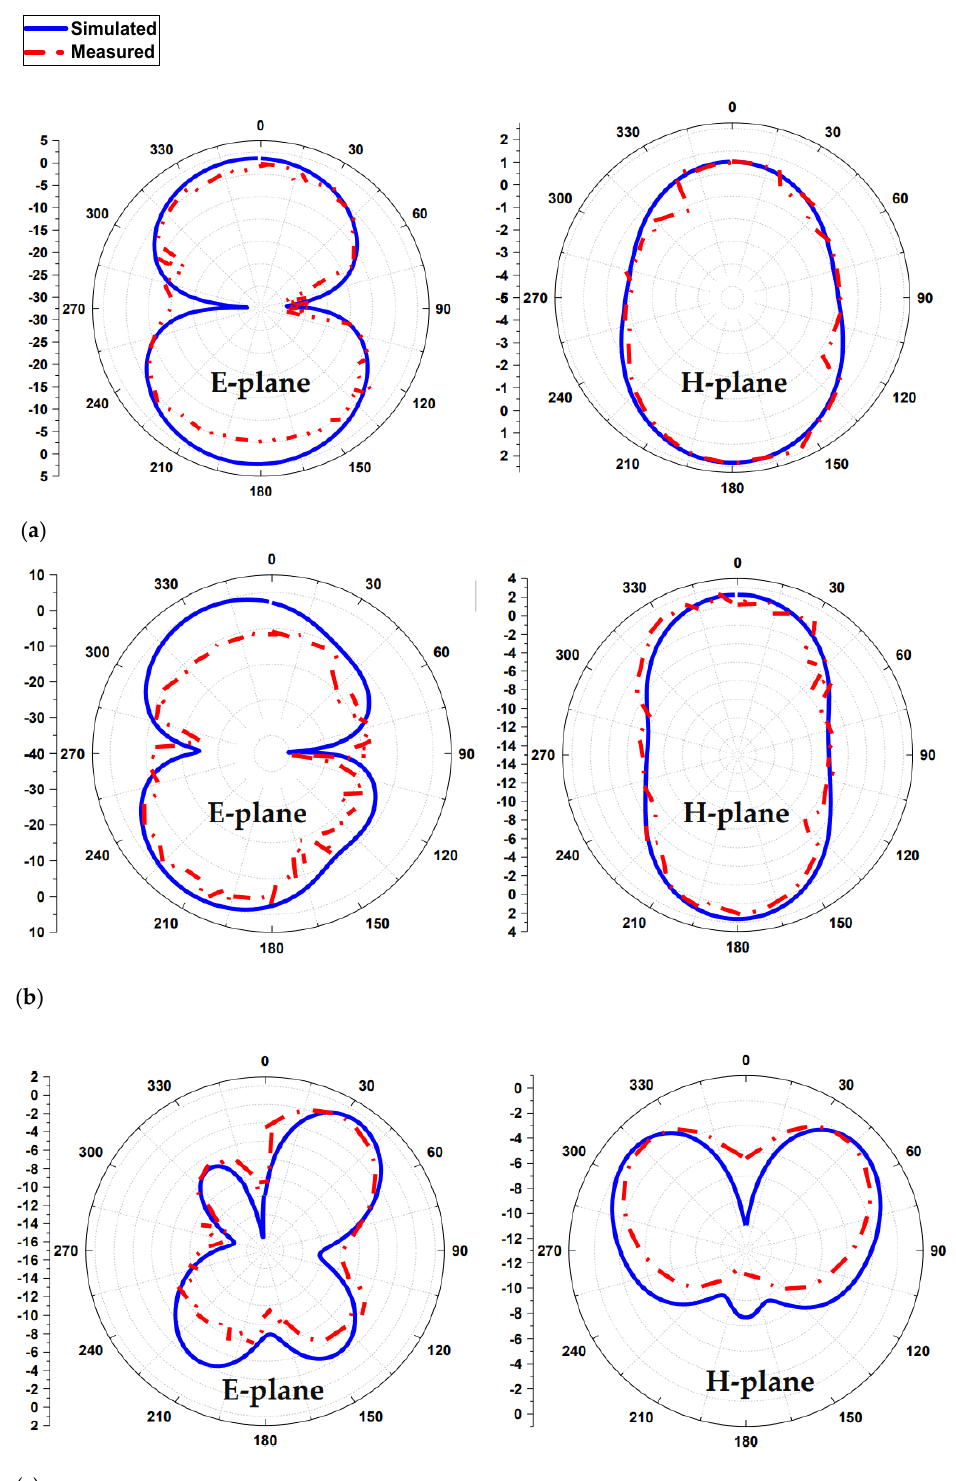
Figure 9. 2D radiation pattern ( a ) at 1.8 GHz, ( b ) at 3.5 GHz, and ( c ) at 5.4 GHz.